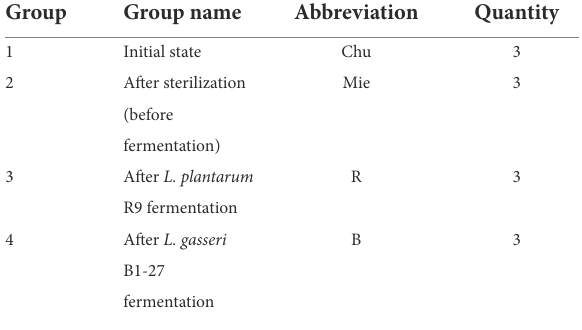
TABLE 3 Metabolomics sample group information.